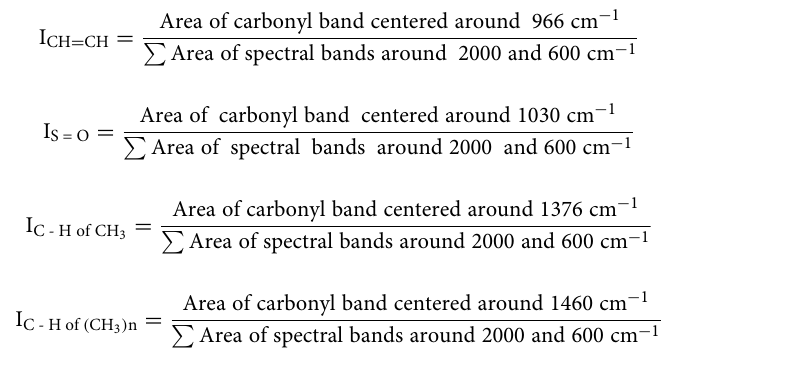
Figure 6. Infrared thermal image evaluation of asphalt binder specimens: ( a - d ) warm mix asphalt (WMA) additive and FSN, ( e – h ) WMA additive and without FSN, ( i - l ) FSN and without WMA additive, and ( m - p ) without WMA additive and without FSN; in different thermal zones: ( a , e , I , m ) 30 s, ( b , f , j , n ) 60 s, ( c , g , k , o ) 90 s, and ( d , h , l , p ) 120 s. The diameter of the specimen is 18 additive. Figure 6c-h,m-p shows that the release heat rate of asphalt binders with and without FSN are 0.66 and 0.68 °C/s, respectively. This indicates that FSN has slightly better performance in the temperature distribution. In addition, this observation may be linked with recent findings from Badroodi et al. 51 , indicating that FSN sup- port self-healing in asphalt binders. Figure 7a shows the FTIR spectra of FSN-modified and control binder samples. The infrared spectrum of chemical bonds were found to be reflected in various locations. The sulfoxides, the carbonyls, the aromatics, the polyaromatics, and the aliphatic hydrocarbons groups are created by oxidative aging from carbon–carbon or carbon–hydrogen bonds. In order to calculate the change of chemical bonding, the following equations were used according to 52,53 :